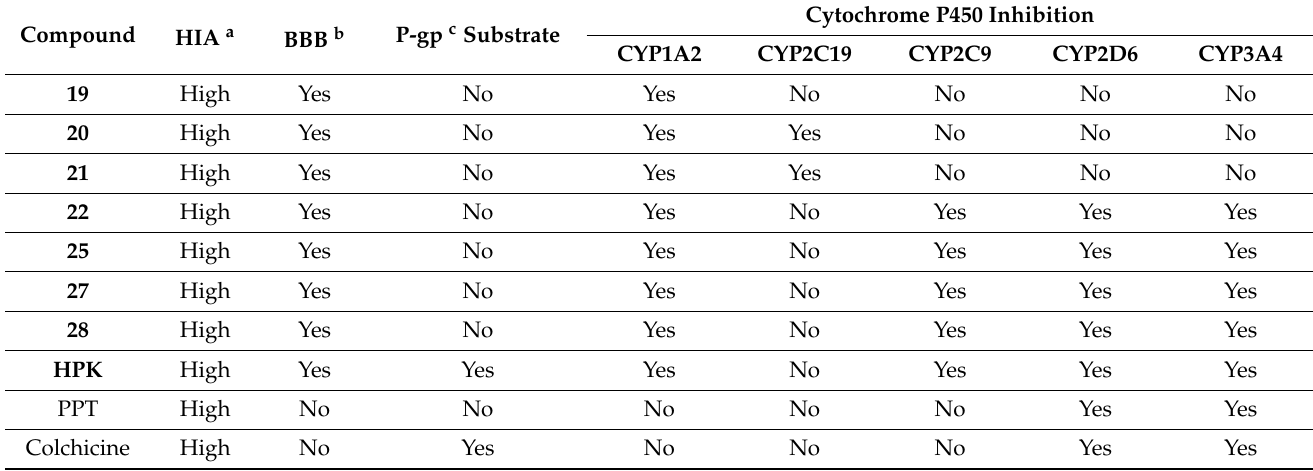
Table 7. ADMET analysis of 4-PQ compounds, podophyllotoxin (PPT), and colchicine was evaluated by SwissADME [41].